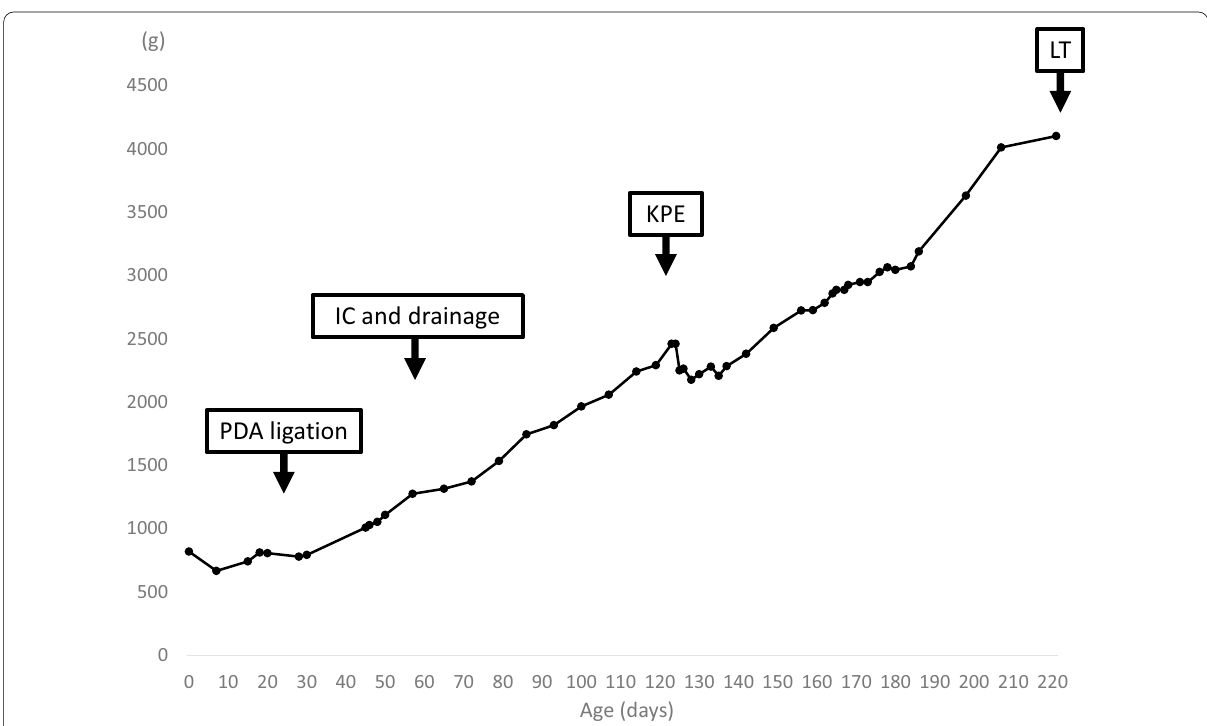
Fig. 4 The trend in body weight. PDA patent ductus arteriosus, IC intraoperative cholangiography, KPE Kasai portoenterostomy, LT liver